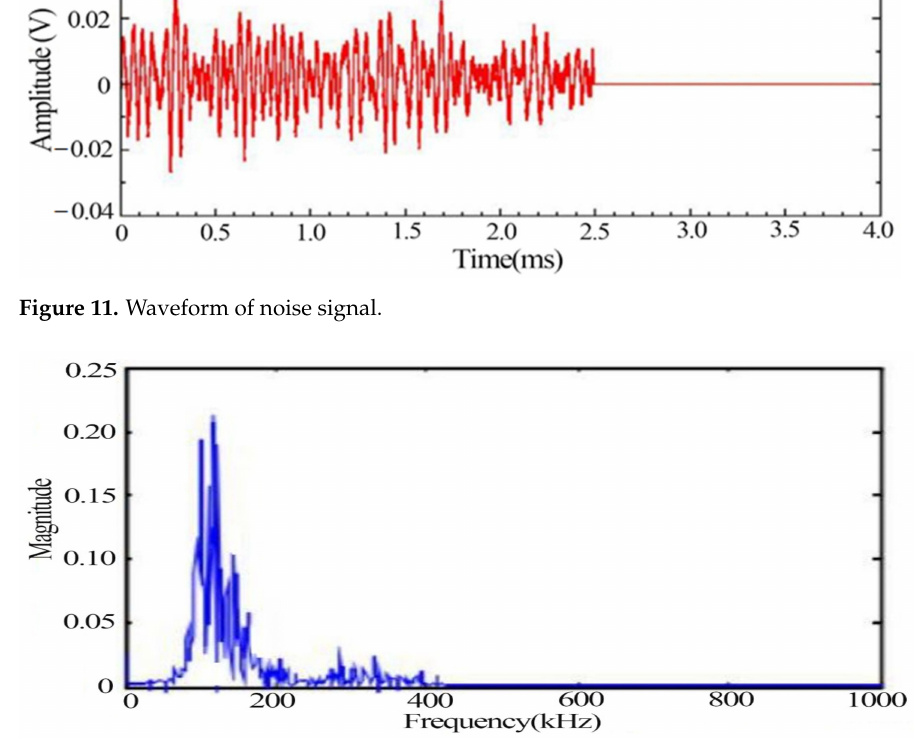
Figure 12. Spectrum of noise